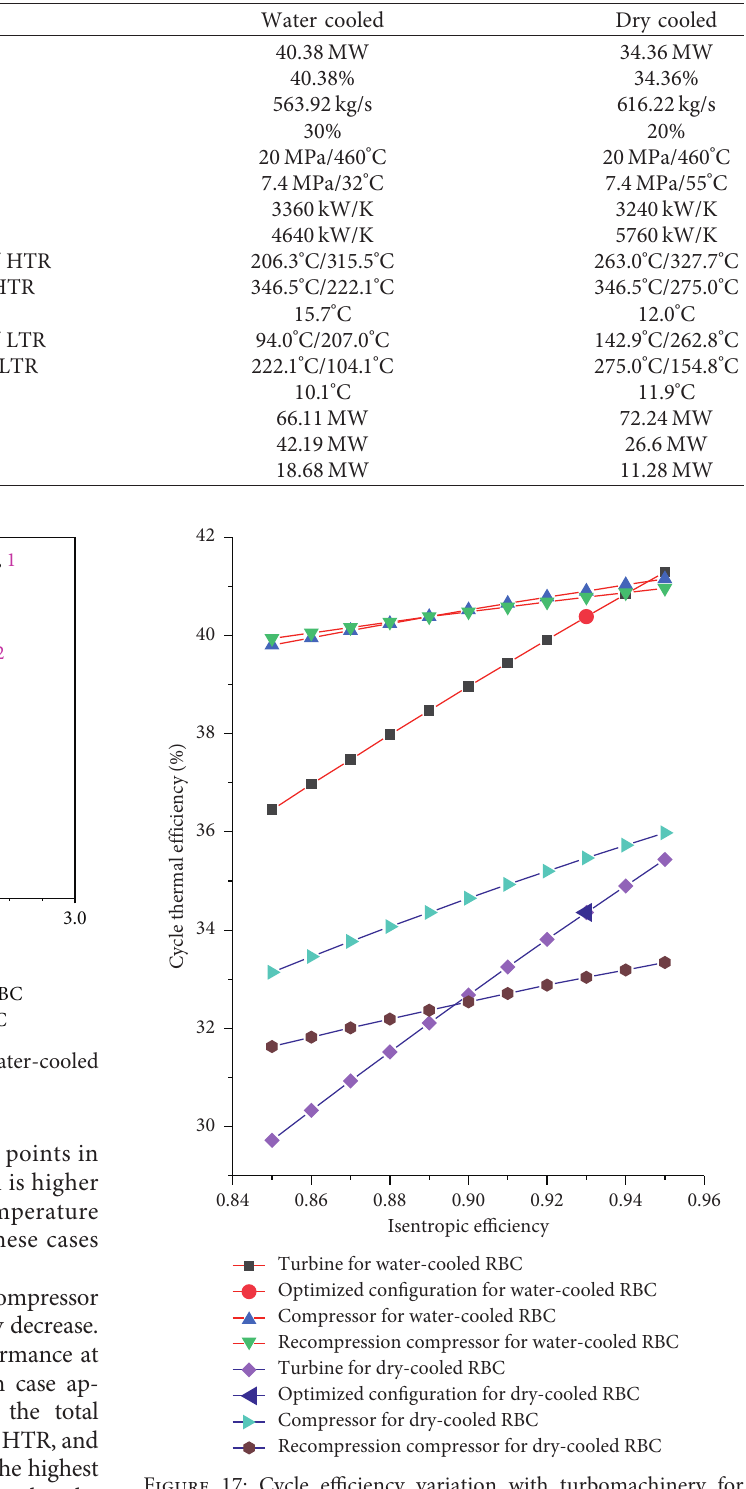
Table 6: Optimal design for the water-cooled recompression Brayton cycle.